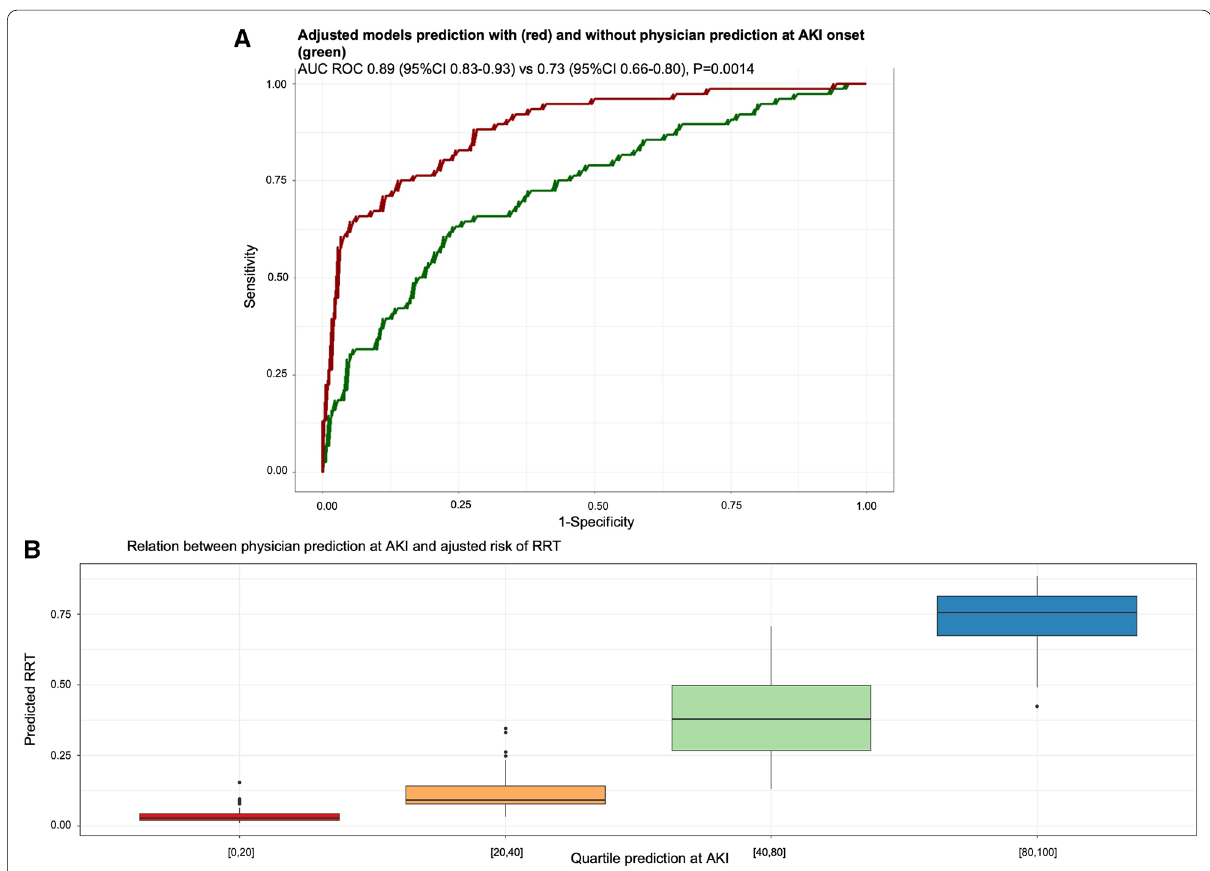
Fig. 3 Adjusted models prediction of physician prediction at AKI diagnosis ( A ) and relation between physician prediction and adjusted risk of RRT ( B ) . AKI acute kidney injury, RRT renal replacement